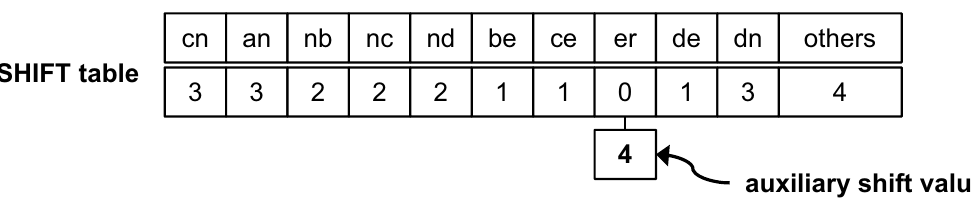
Figure 3. Shift table with auxiliary shift